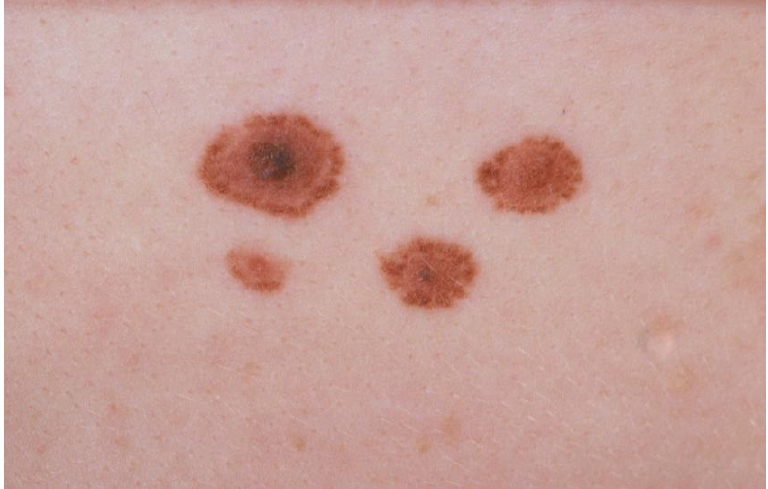
Figure 1. Classical example of an atypical nevus with asymmetry, color irregularity and a diameter of more than 5